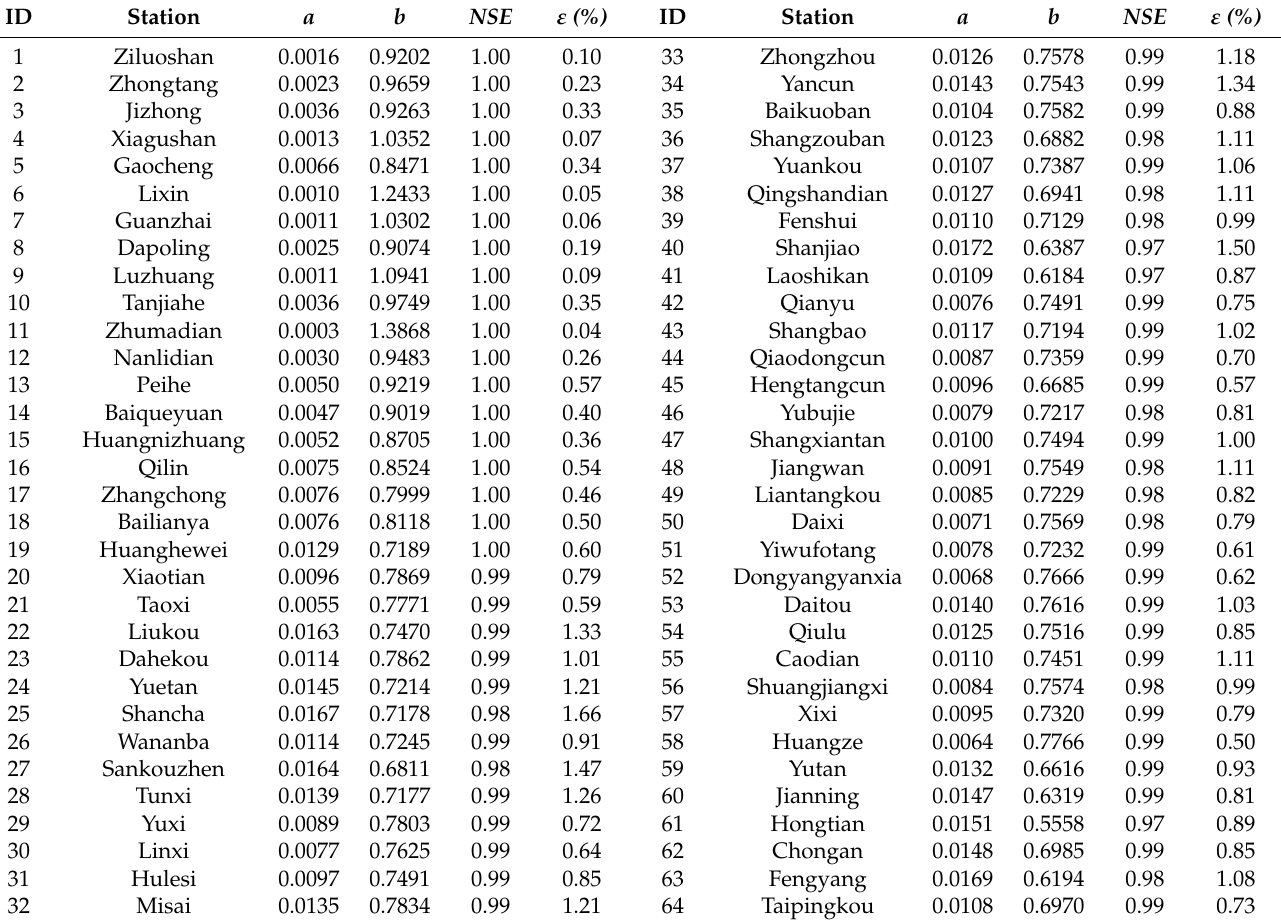
Figure 2. The box charts of ( a ) the Nash–Sutcliffe efficiency ( NSE ) and ( b ) the relative mean square error ( ε ) values between the fitted FDCs and the observed FDCs for the 64 basins with the five models, including power, exponential, logarithmic, quadratic and cubic models. Table 2. Parameters a and b of the power model and the NSE and ε values in the FDC fit for each